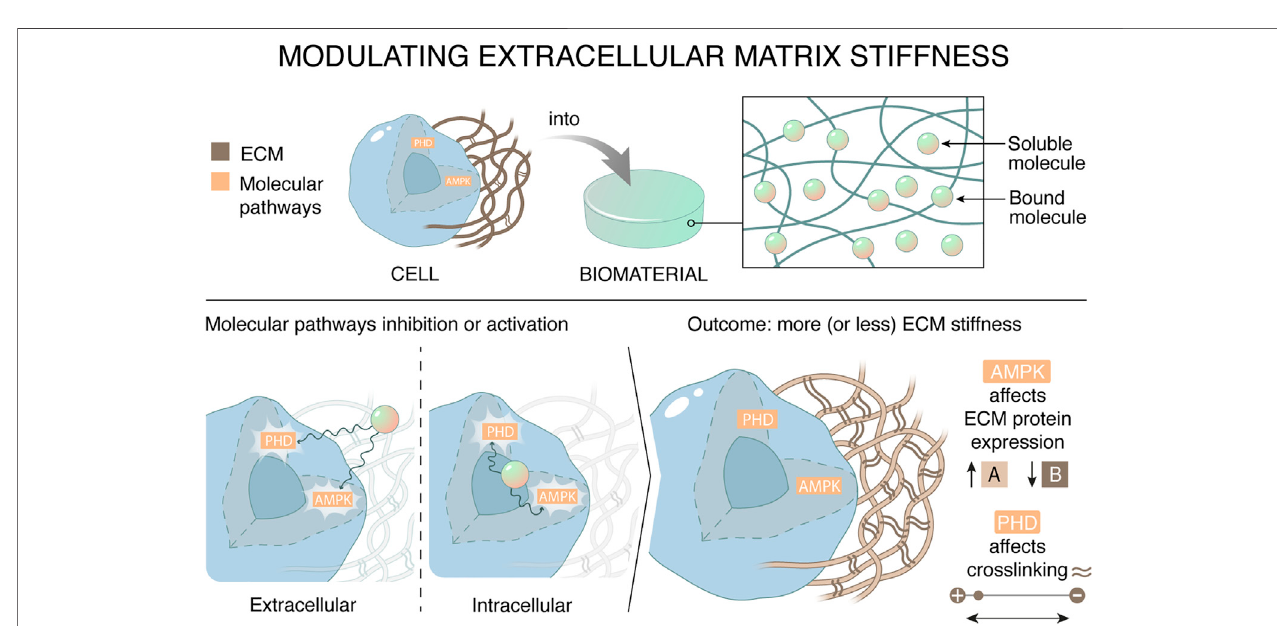
FIGURE 1 | Materials can affect the stiffness of the extracellular matrix by regulating cellular metabolism. The synthetic drug delivery system targets metabolic mediators AMP-activated protein kinase (AMPK) and prolyl hydroxylases in tissue resident cells, which in their turn decreases ECM stiffness. There are two ways to regulate the outcome of ECM stiffness, namely by affecting ECM expression or by affecting ECM crosslinking. This can be achieved by targeting metabolic pathways by scavenging essential cofactors extracellularly or directly inhibiting metabolic targets.